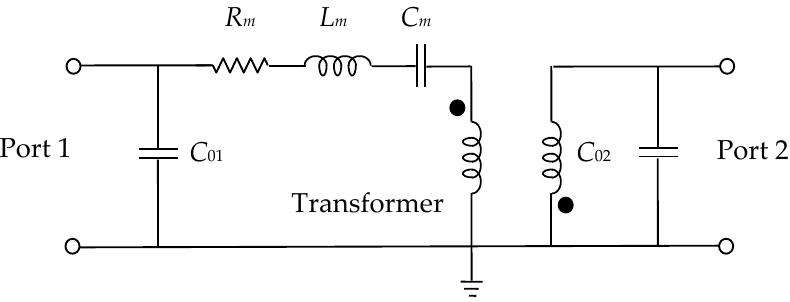
Figure 3. Electrical equivalent-circuit model for a two-port SAW resonator.